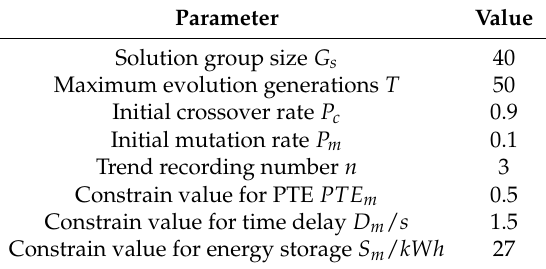
Table 1. Optimization parameters.